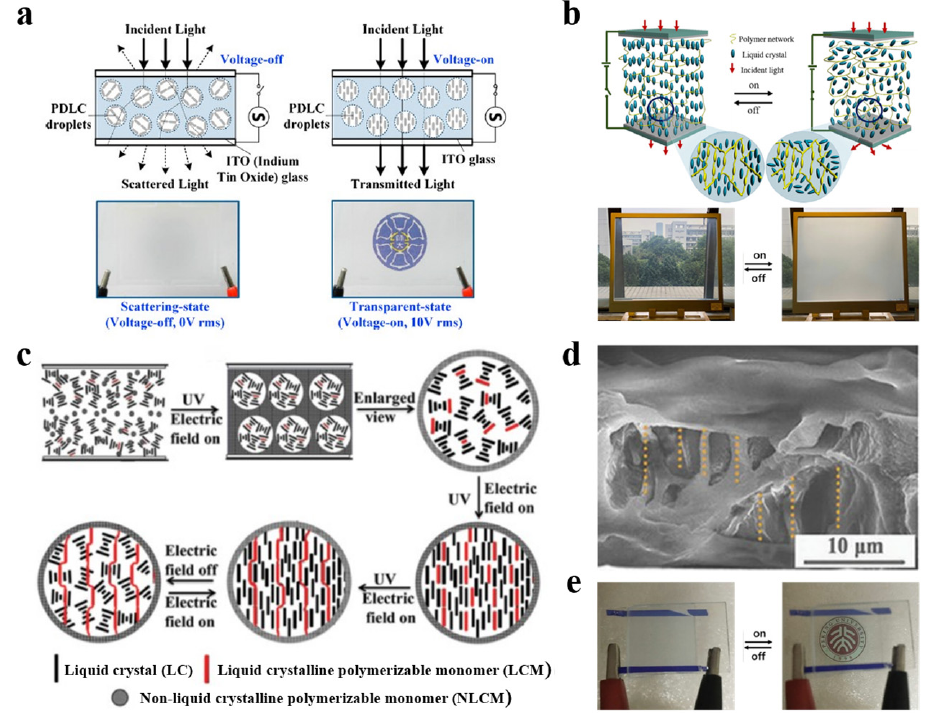
Figure 2. Schematic representation of the working principle and image of ( a ) PDLC [62] and ( b ) PSLC [64] smart windows. ( c ) The schematic illustration for preparing the PD&SLC [68]. ( d ) Cross- sectional scanning electron microscopy (SEM) image of PD&SLC polymer network [68]. ( e ) Photo- graph of PD&SLC in the OFF/ON states [68].